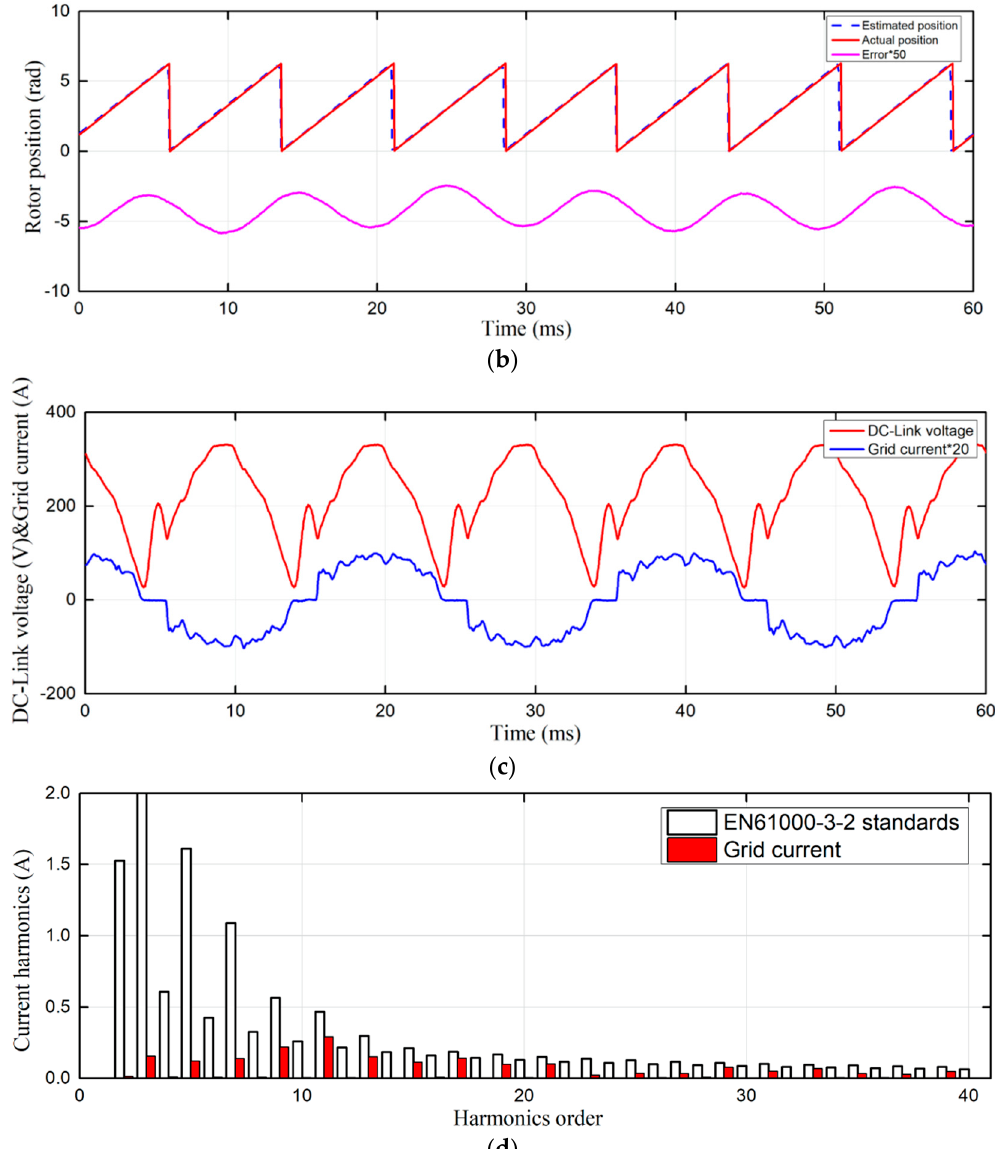
Figure 18. Experiment with conventional SMO only with a PIR controller: ( a ) Motor Speed; ( b ) Position and estimated error; ( c ) DC-link voltage and grid current; ( d ) FFT analysis of grid current.